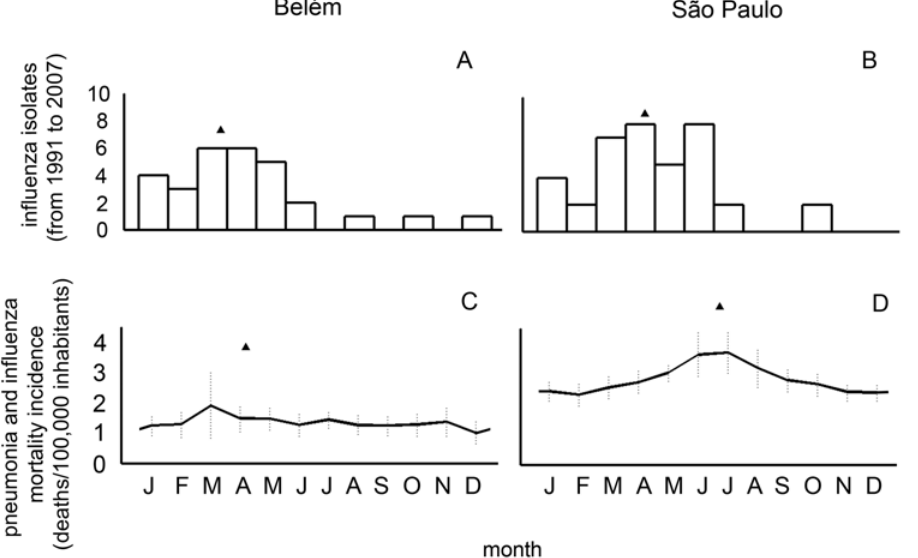
Figure 2. Comparison of influenza seasonal patterns in Bele´m and Sa˜o Paulo using laboratory versus vital statistics data. Top panels (A,B) are based on monthly laboratory-confirmed influenza surveillance between 1991 and 2007 Bottom panels (C,D) illustrate monthly mortality rates per 100,000 from pneumonia and influenza (P&I) between 1996 and 2005. Standard deviation are represented as vertical bars. Triangles in each panel represent the mid-point of the influenza season, based on azimuthal (circular)